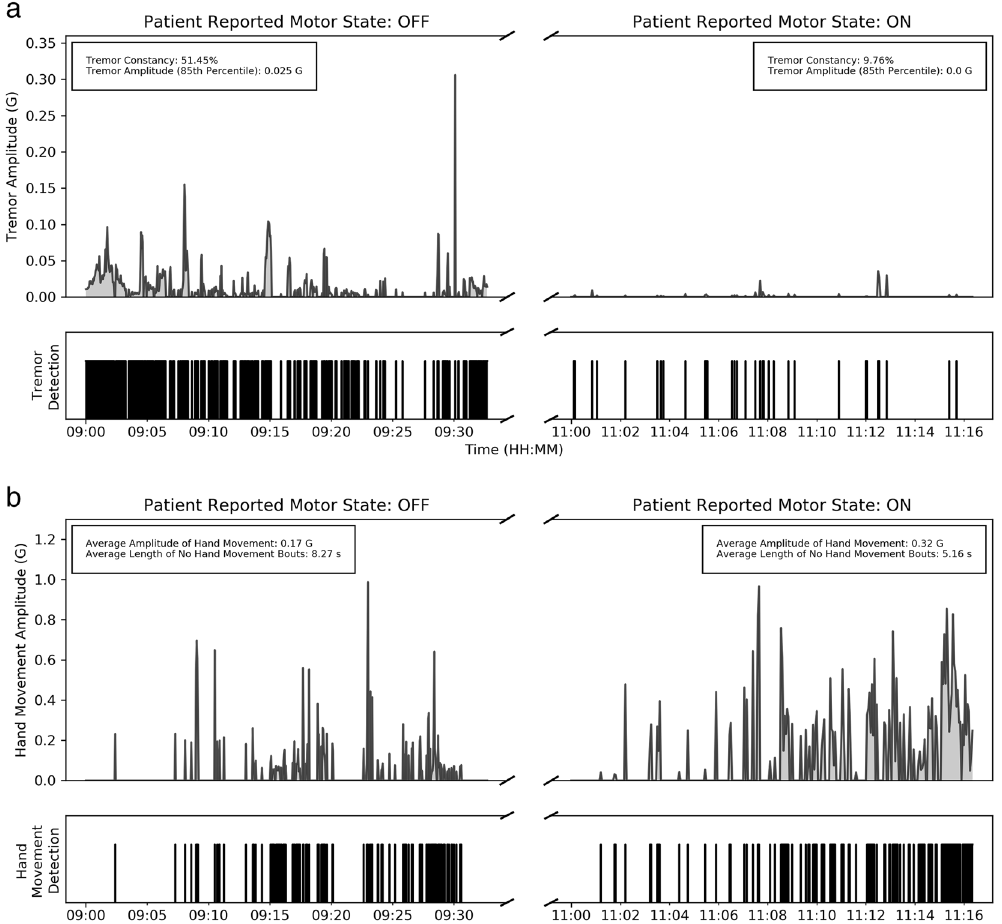
Fig. 7 An example showing continuous assessment of resting tremor and bradykinesia using accelerometer data from a device worn on the most affected wrist. Data was collected on one PD patient across two in-lab visits. The fi rst visit was in the OFF state and second visit in the ON state. a Continuous tremor detection and tremor amplitude measurement in the OFF (left panel) and ON (right panel) state. Inset shows aggregate measures of tremor constancy and tremor amplitude. Tremor constancy was rated 3 in the OFF state and 1 in the ON state. Tremor amplitude was rated 2 in the OFF and 0 in the ON. b Continuous hand movement detection and hand amplitude measurement in the OFF (left panel) and ON (right panel) state. Inset shows aggregate measures of hand movement amplitude and length of no hand movement bouts. Hand bradykinesia was rated 9 in the OFF state and 2 in the ON